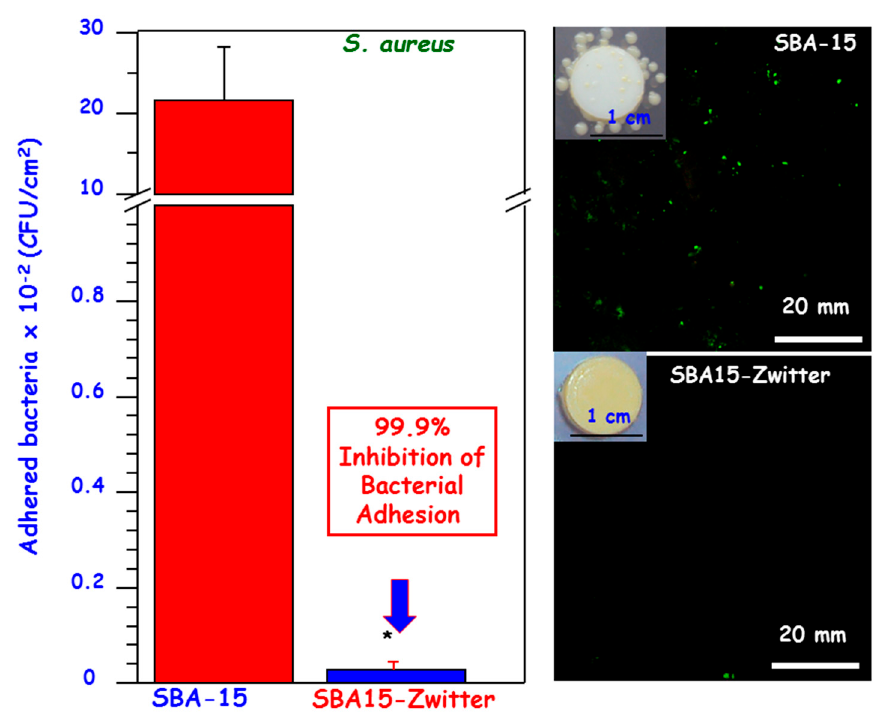
Figure 6. Schematic depiction of pure silica SBA-15 and zwitterionic SBA-15 (SBA-Zwitter) nanostructured materials. SBA-Zwitter was prepared following the co-condensation route in the presence of DAMO. Counting of colony forming units of S. aureus after 90 min of culture onto SBA-15 and SBA15-Zwitter surfaces. Statistical significance: * p < 0.01. Confocal microscopy images of S. aureus adhered onto SBA-15 and SBA15-Zwitter surfaces after staining with Baclight ®